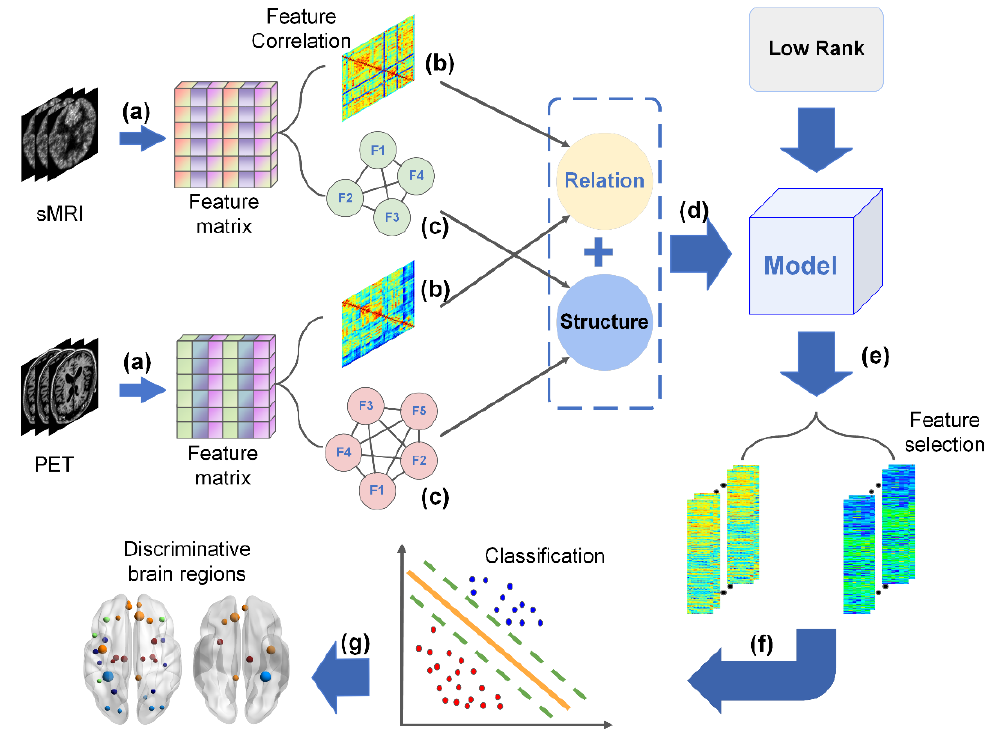
Figure 1. The research framework. ( a ) Original sMRI and PET images were preprocessed, then regions of interest were extracted by AAL template as sMRI and PET features, and the corresponding feature matrices of sMRI and PET were obtained, respectively. ( b ) Correlation coefficients between feature nodes of each modal data were calculated to obtain the feature correlation matrix, and the feature correlation regularization was obtained by linear fusion. ( c ) Feature matrix was weighted fusion, then the adjacent nodes were calculated to obtain the adjacency matrix, and the feature graph Laplacian matrix was constructed according to the cosine distance method to obtain the feature structure regularization. ( d ) The two regularizations were embedded into the multi-task model with low-rank constraint for feature selection. ( e ) Feature vectors with good characterization were selected by the proposed model, standardized respectively, and the features extracted from multi-modal data were linearly fused to obtain a new fused feature matrix. ( f ) The test set and training set were divided from the fused feature matrix, the training set was trained by the 10-fold cross-validation method and SVM to obtain the classification model, and the classification performance of the model was verified by the test set; ( g ) The corresponding discriminative brain regions of the selected feature nodes were visualized to analyze the discriminative brain regions affected by MCI and AD respectively.